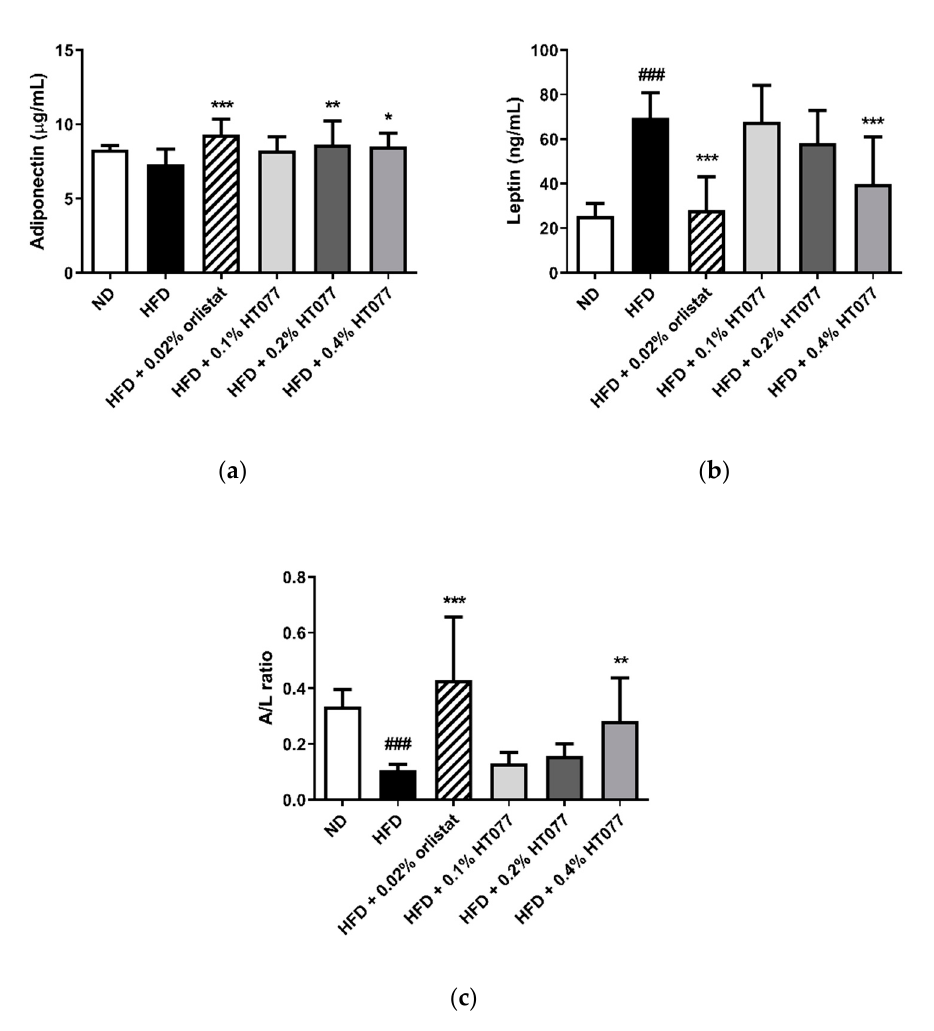
( b ) Figure 5. Effects of an extract mixture of Prunus persica and Nelumbo nucifera (HT077) on hepatic triglyceride ( a ) and total cholesterol ( b ) contents in C57BL/6 mice fed a high-fat diet (HFD). Mice received either a normal diet (ND), HFD, HFD containing 0.02% orlistat, or HFD containing 0.1, 0.2, or 0.4 HT077 for 12 weeks. All values are presented as the mean ± SD ( n = 8 for ND, 16 for HFD, and 12 for the other groups). # p < 0.05 vs. ND group. * p < 0.05 and ** p < 0.01 vs. HFD control group. TC, total cholesterol; TG, triglyceride.